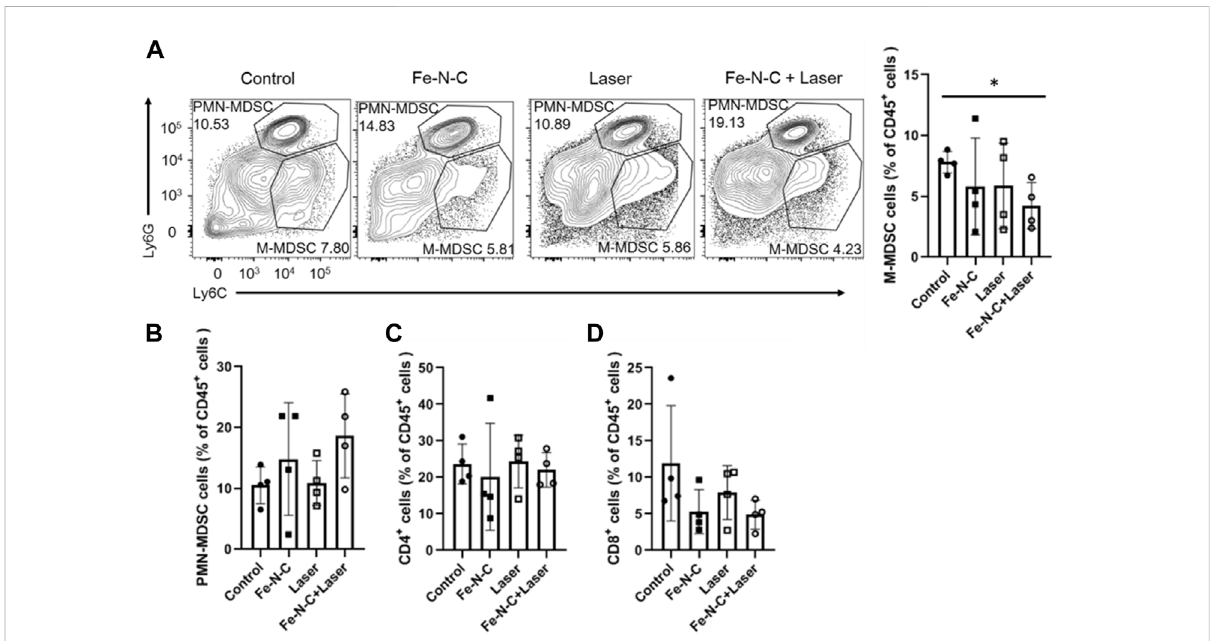
FIGURE 9 Fe-N-CSAzymes breaksinnate immune tolerance. (A) Flow cytometry analysis ofthepercentageofM-MDSCcellsexpressingCD11b+,Ly6C+ and Ly6G-markers. (B) Flow cytometry analysis of the percentage of PMN-MDSC cells expressing CD11b+, Ly6C- and Ly6G + markers. (C) Flow cytometry analysis of the percentage of CD4 + cells expressing CD11b- and CD4 + markers. (D) Flow cytometry analysis of the percentage of CD8 + cellsexpressingCD11b-andCD8 α +markers.Dataarerepresentativeoftwoindependentexperiments.Summarydataareshownasthemean± S.E.M. with p values determined by two-tailed Student ’ s t -test (* p < 0.05, ** p < 0.01, *** p < 0.001, **** p <